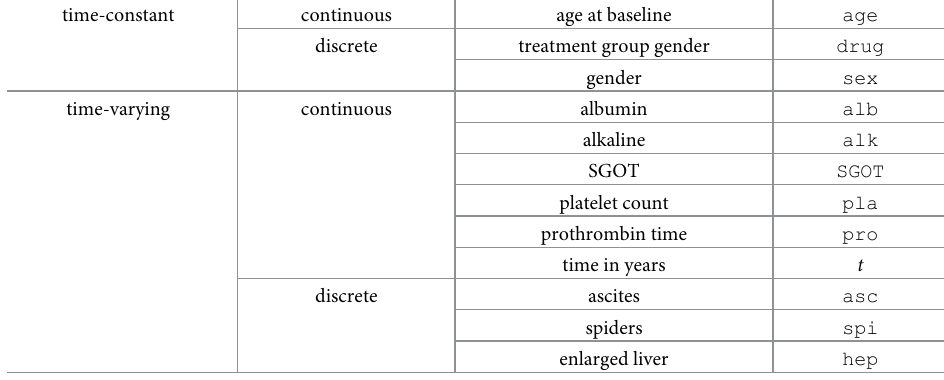
Table 9. Variables of the PBC data set. drug and sex are dummies for treatment group and female gender. Ascites is the abnormal buildup of fluid in the abdomen and spiders are blood vessel malformations in the skin. SGOT is short for serum glutamic oxaloacetic